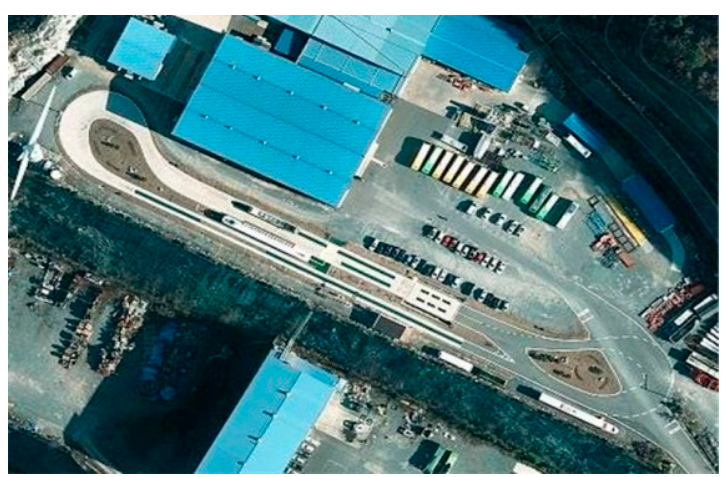
Figure 2. Test track.